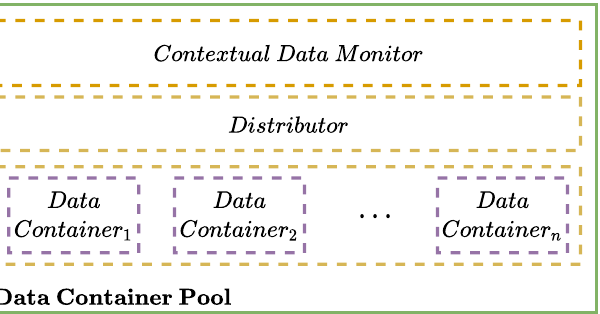
Figure 2. Stack representation of a temporal storage service created by using a data container